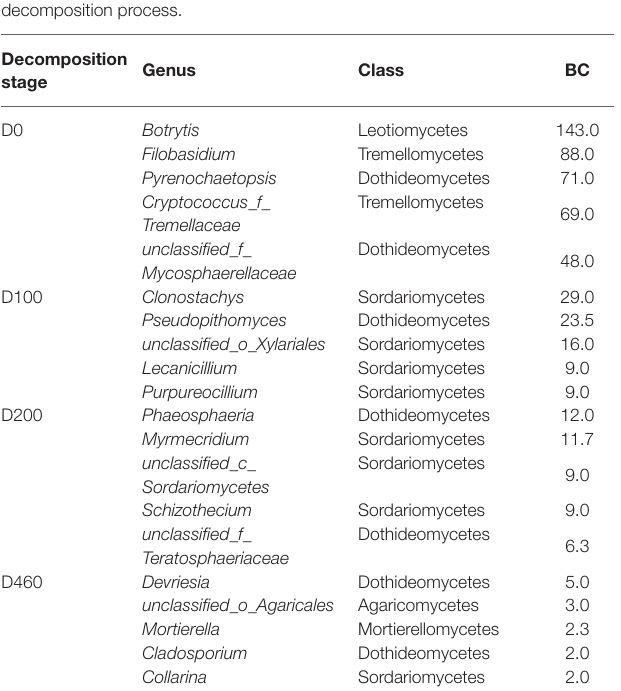
TABLE 2 | Key fungal genera in correlation network during the litter decomposition process. Decomposition